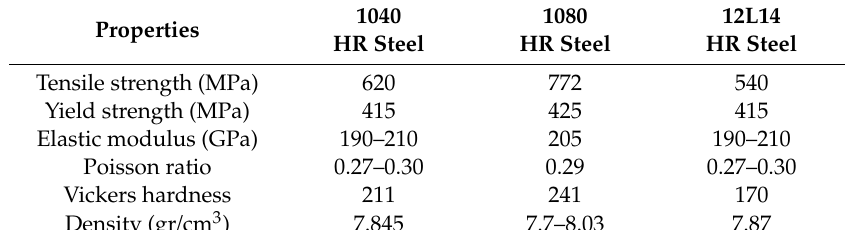
Table 1. Properties of three different hot-rolled (HR) steel materials.